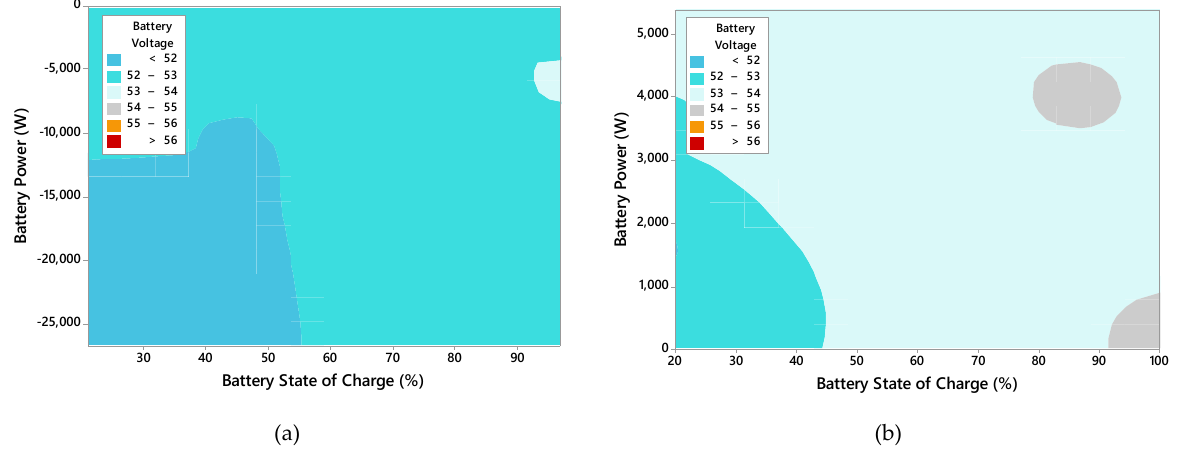
Figure 14. Voltage variation in function of batteries power and SoC for: ( a ) discharging cycle and ( b ) charging cycle. Temperature is another important parameter in the batteries’ operation, and to analyze it, correlation plots of its variation in function of the SoC and the power delivered in the charge/discharge cycle were created and are presented in Figure 15. In discharging mode (Figure 15a), it is observed how the temperature increases as the state of charge decreases, mainly for SoC < 45% and discharge powers > 15 kW. For the charging cycle, on the other hand, the temperature does not show considerable increases, with higher temperatures at the beginning of the recharge process and in the final phase, as shown in Figure 15b. ( b ) Figure 15. Temperature variation in function of batteries soc and power for: ( a ) discharging cycle and ( b ) charging cycle. To better assess the relationship between the variables associated with the storage system, as well as their influences, a Spearman’s correlation analysis was developed in Minitab 18 [43], between the storage system voltage, current, temperature, power and state of charge, as well as the demanded load power and the PV-CEAMAZON 02 and 03 systems. Figures 16 and 17 present the correlation matrices between the analyzed varia- bles.